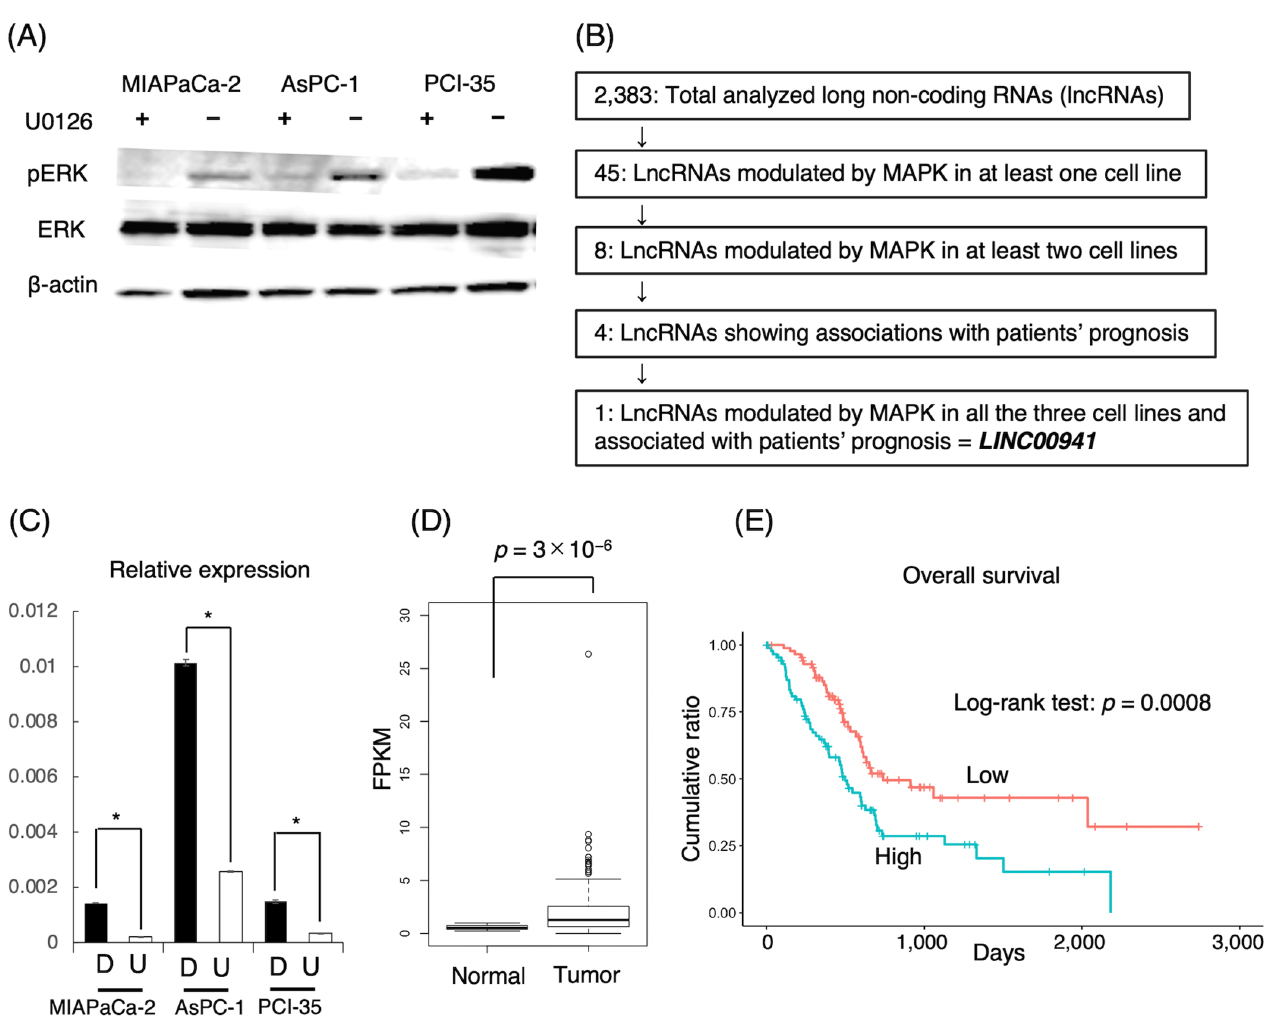
Figure 1. MAPK-associated lncRNAs identified by a comparative transcriptome sequencing assay of pancreatic cancer cells with or without attenuation of MAPK activity. ( A ) The expression of phosphorylated ERK was inhibited by U0126, a MAP2K inhibitor, in pancreatic cancer cell lines. ( B ) Stringent processing of transcriptome sequencing data resulted in identification of MAPK-associated lncRNAs. ( C ) qRT-PCR assay validated the transcriptome data revealing downregulation of LINC00941 by the attenuation of MAPK in pancreatic cancer cell lines (* p < 0.05). Abbreviations: D, DMSO; U, U0126. ( D ) TCGA data analysis showed that LINC00941 was expressed significantly more highly in pancreatic cancer tissues than in normal tissues ( p = 3 × 10 − 6 ). ( E ) TCGA data analysis showed that highly expressed LINC00941 in pancreatic cancer tissues was associated with patients’ poor overall survival ( p = 0.0008).